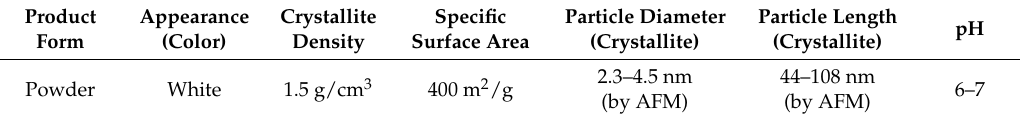
Table 3. Physical properties of CNCs used.